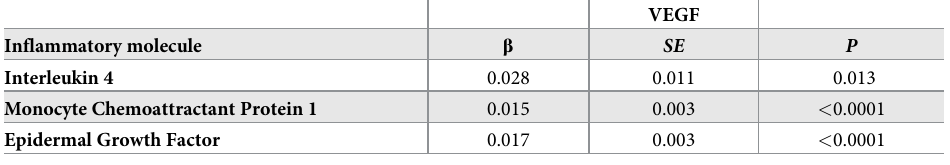
Table 3. Significant determinants of VEGF protein levels extracted from PBMCs (linear regression analyses adjusted for age and